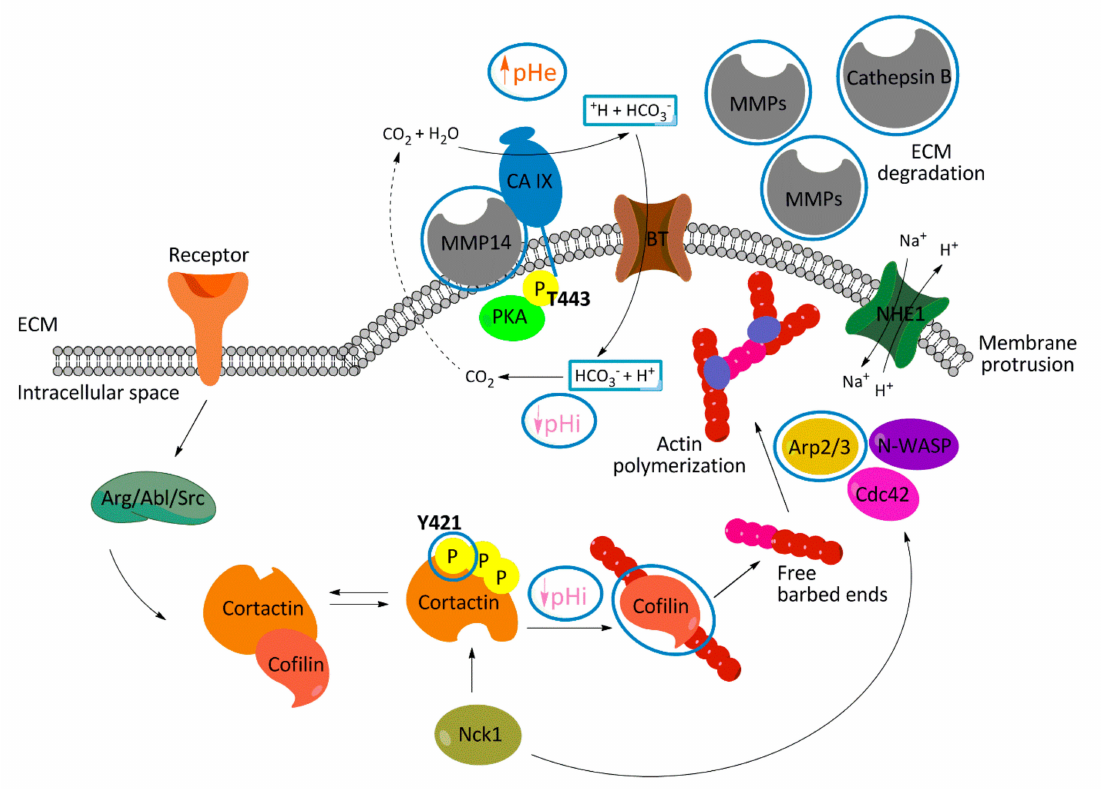
Figure 7. Hypothetical model depicting the consequences of downregulation of CAIX expression (denoted by blue circles) on mechanisms that modulate processes required for the invadopodia development. Acidic extracellular pH is indispensable for invadopodia formation, proteolytic cleavage of extracellular matrix and cancer cell invasion. Enzymatic activity of CAIX regulated by protein kinase A (PKA) generates acidic pHe nanodomains promoting the activity of MMPs. The functional cooperation between CAIX and bicarbonate transporters (NBCe1) in invadopodia locally increases pHi and releases pH-dependent cortactin-cofilin binding to promote actin-free barbed end formation. When CAIX is depleted, extracellular pH increases, intracellular pH becomes less alkaline, phosphorylation of Y421-cortactin is reduced, and Arp2 expression is lowered. These CAIX-related changes attenuate invadopodia formation and actin polymerization. Altogether, CAIX-mediated pH regulation as well as CAIX expression enhances proteolytic activity in invadopodia and a ff ects actin-regulating proteins essential for invadopodia